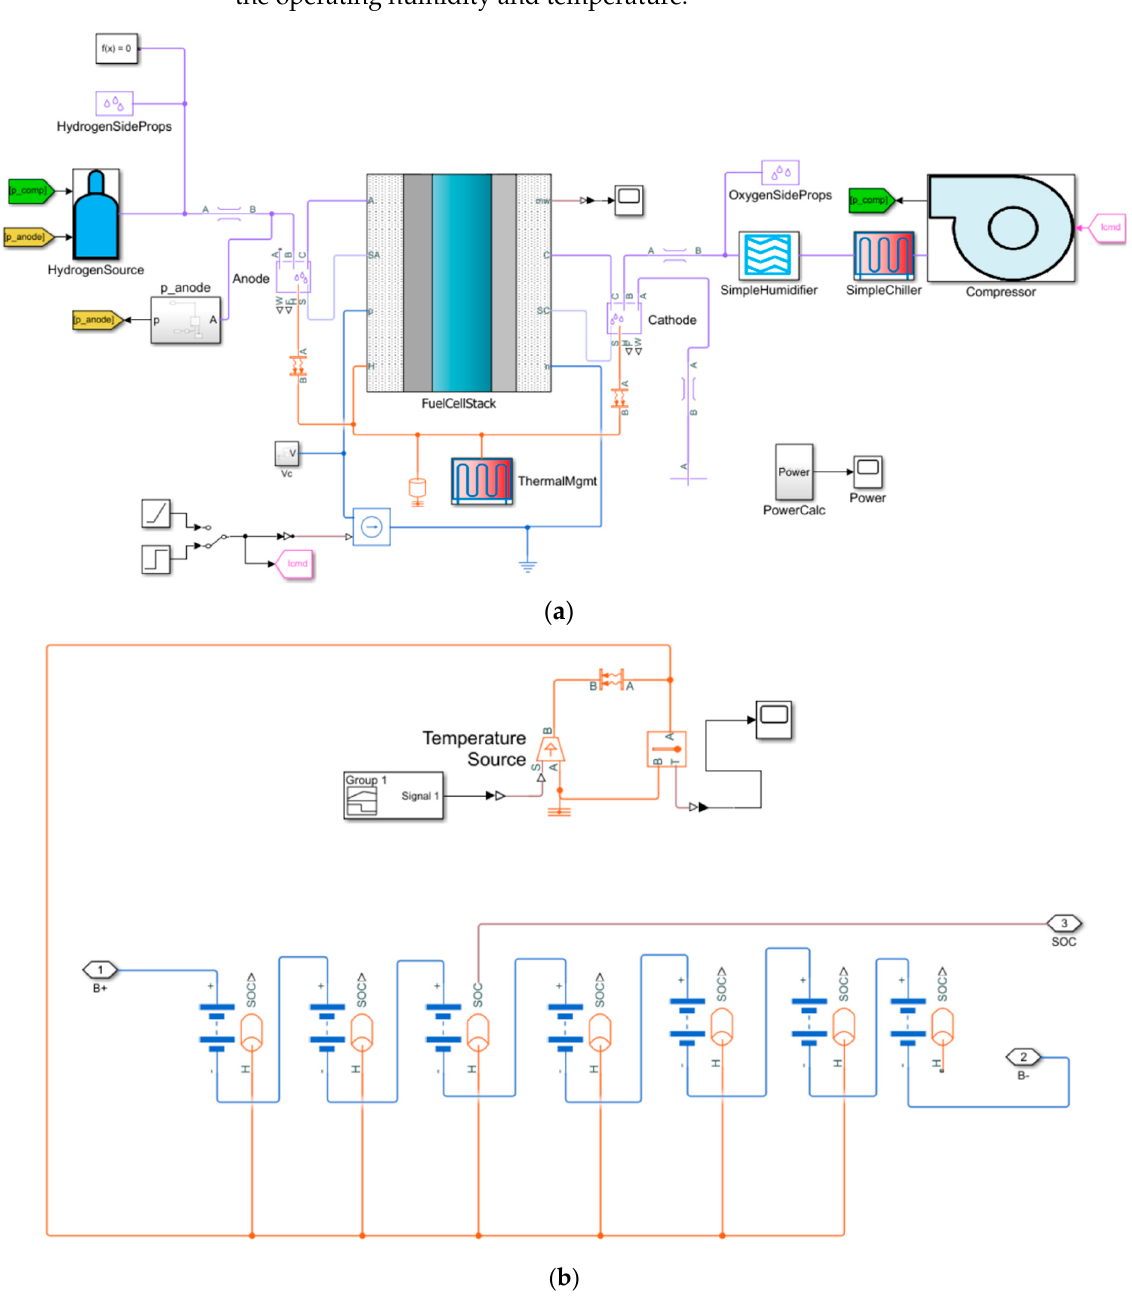
Figure 1. The proposed design of the fuel-cell and battery units in the suggested hybrid system: ( a ) detailed schematic of the fuel-cell unit, ( b ) detailed schematic of the battery unit.